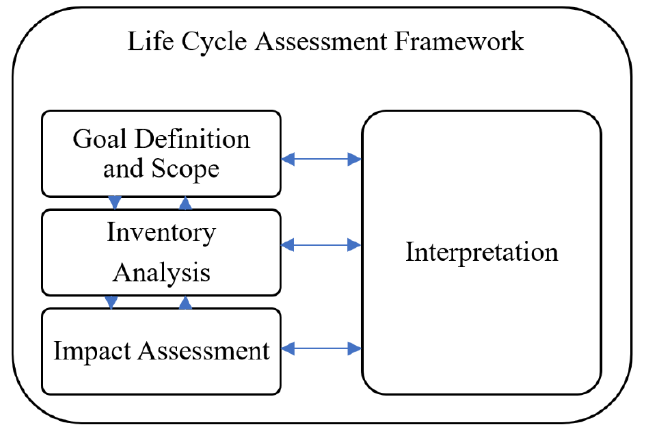
Figure 3. Life Cycle Assessment Framework. Source: ISO. Environmental management — Life Cycle Assessment — Principles and Framework. International Organization for Standardization 2011 , 3 , 20.